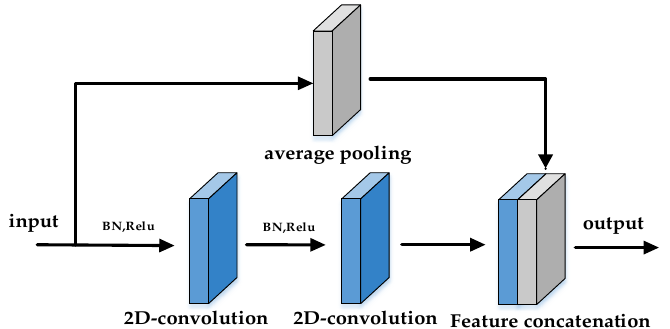
Figure 6. Schematic diagram of the 2D residual network module structure.